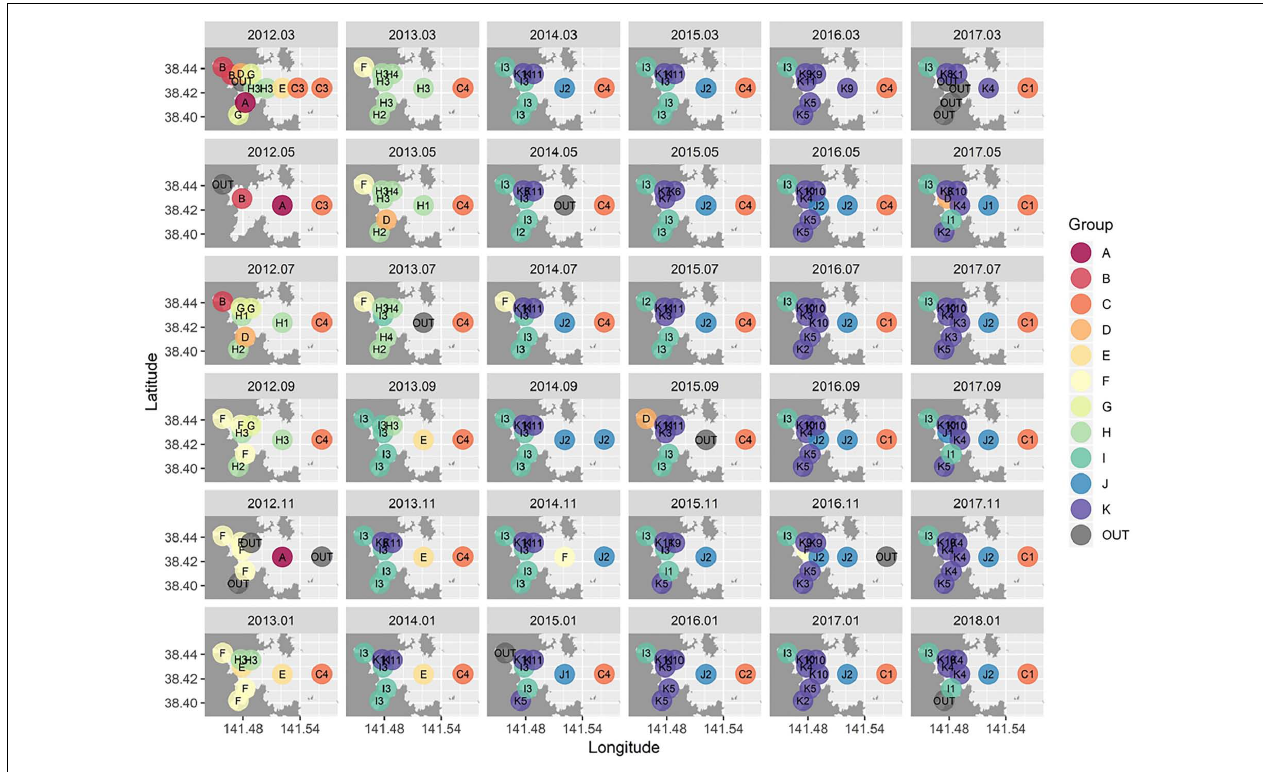
FIGURE 4 | Spatio-temporal distribution maps for benthic macrofaunal community structure in Onagawa Bay from March 2012 (top-left corner) to January 2018 (bottom-right corner). The 11 main clusters (A–K) with a total of 40 significant sub-divided groups (labels in the maps) were identified based on the SIMPROF test ( p <